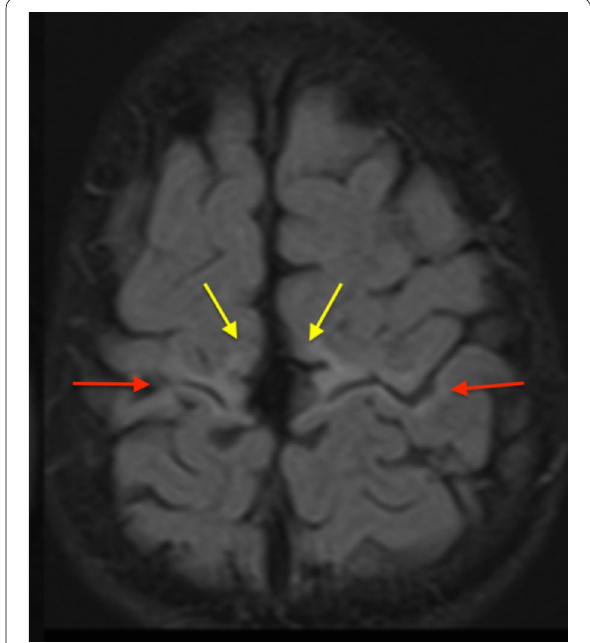
Fig. 3 The moderate subtype of perirolandic injury (red arrows) including partial SMA involvement at the ventral aspect of the PCL (yellow